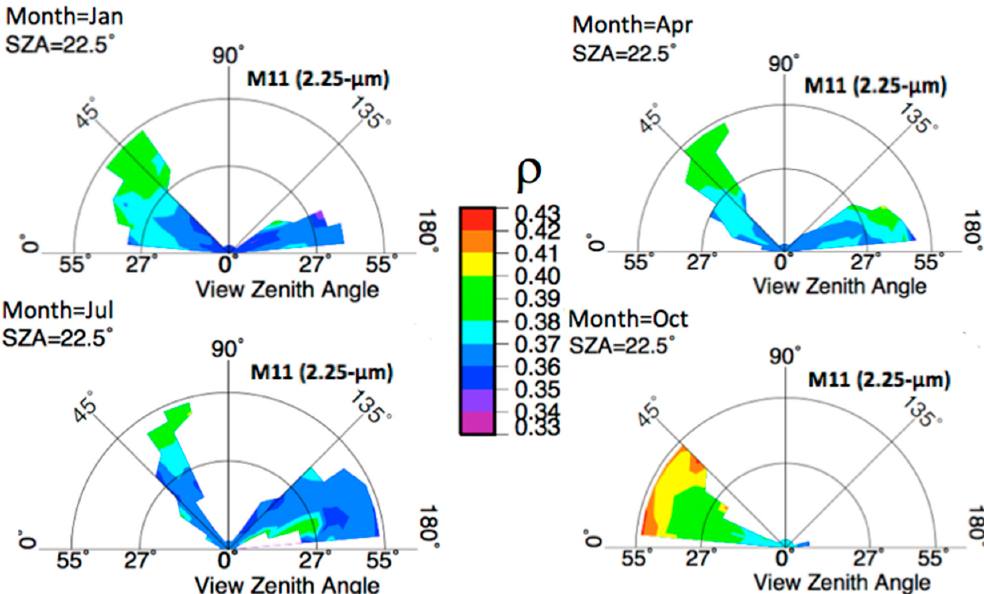
Figure 5. The January, April, July and October DCC reflectances of the VIIRS M11 (2.25 µm) shortwave infrared (SWIR) band reflectances for the 5° SZA bin centered at 22.5°. The VZAs (range 0° to 55°) are shown along the radial coordinate with a 5° bin size, and RAAs are shown on the angular coordinate with a 10° bin size. Forward scattering is found at RAA = 0.